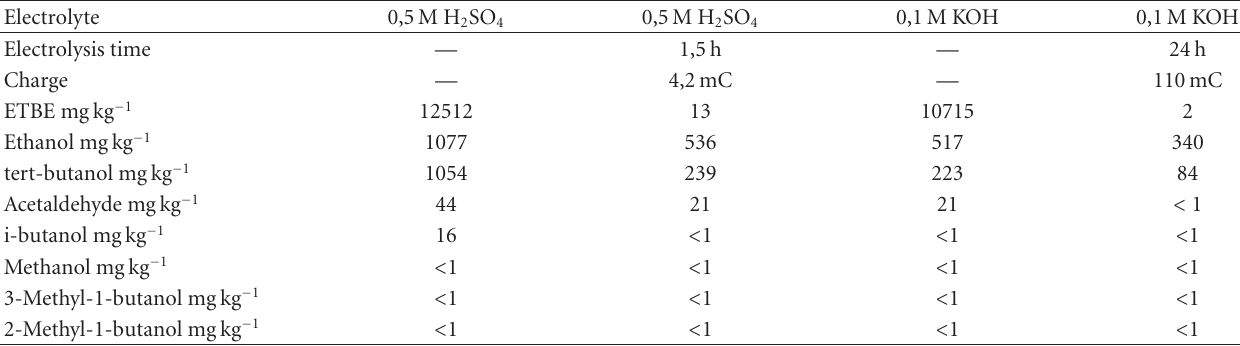
Table 1: Results of the GC/MS analysis of samples containing 1wt.-% ETBE before and after the electrolysis at 0.7 V versus RHE in acidic and alkaline